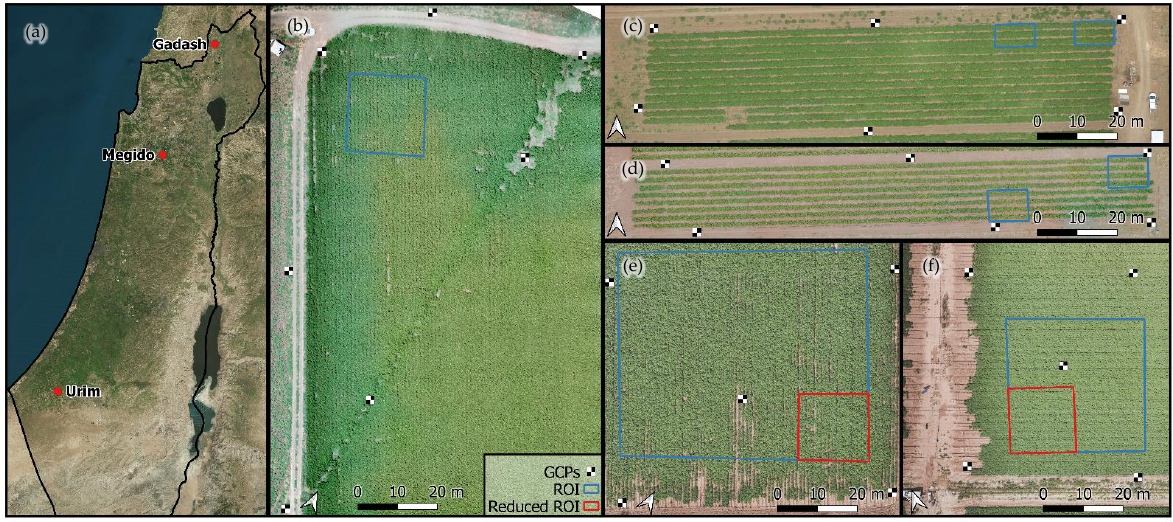
Figure 1. The locations of the study fields in Israel ( a ) and example orthomosaics of the study fields: Megido ( b ), Gadash 2020 ( c ) and 2021 ( d ), and Urim winter ( e ) and spring ( f ). The ground control points (GCPs) are marked with a checkered box, regions of interest (ROI) are marked in blue, and the ROIs with reduced size are marked in red. Table 1. Study field locations and flight configurations. GCPs indicate the number of ground control points used to geo-reference the orthomosaics; # flights indicate the number of flight dates over each field.